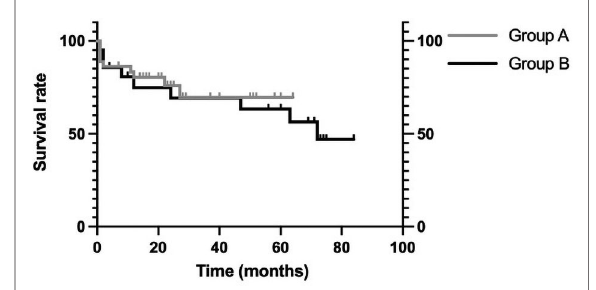
FIGURE 2 Comparison of group A and group B survival rates. There is no signi fi cant difference in the 5-year survival rate between group A and group B (69.6% vs. 63.4% p =0.67).